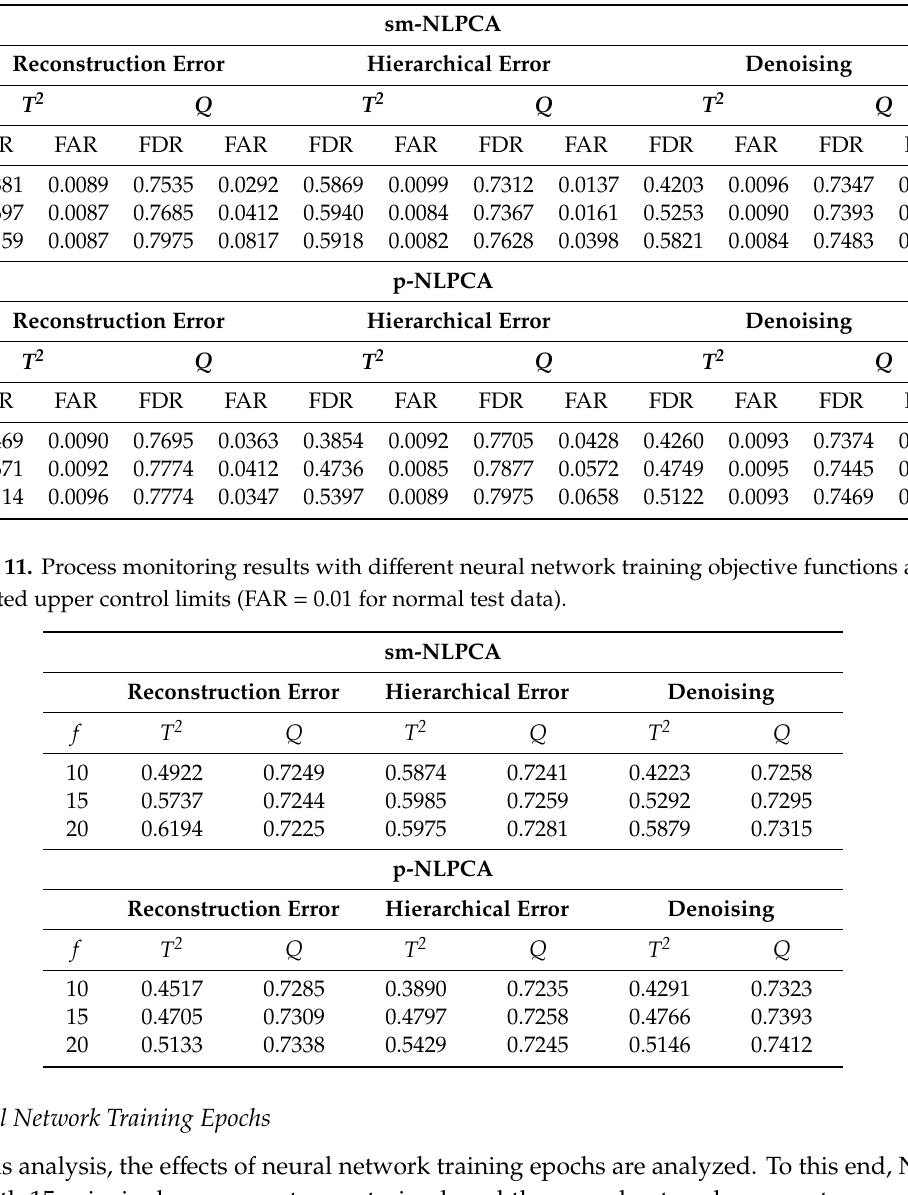
Table 10. Process monitoring results with di ff erent neural network training objective functions.